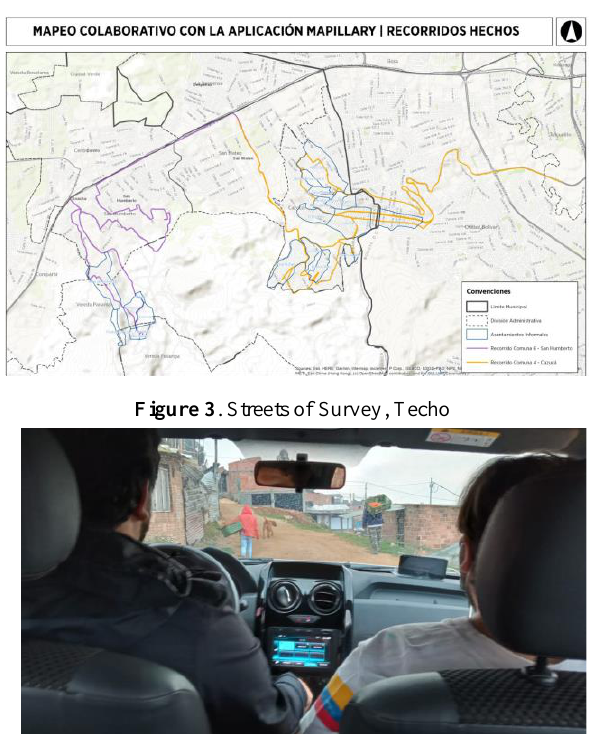
Figure 4 . Pictures of the fieldwork by TECHO